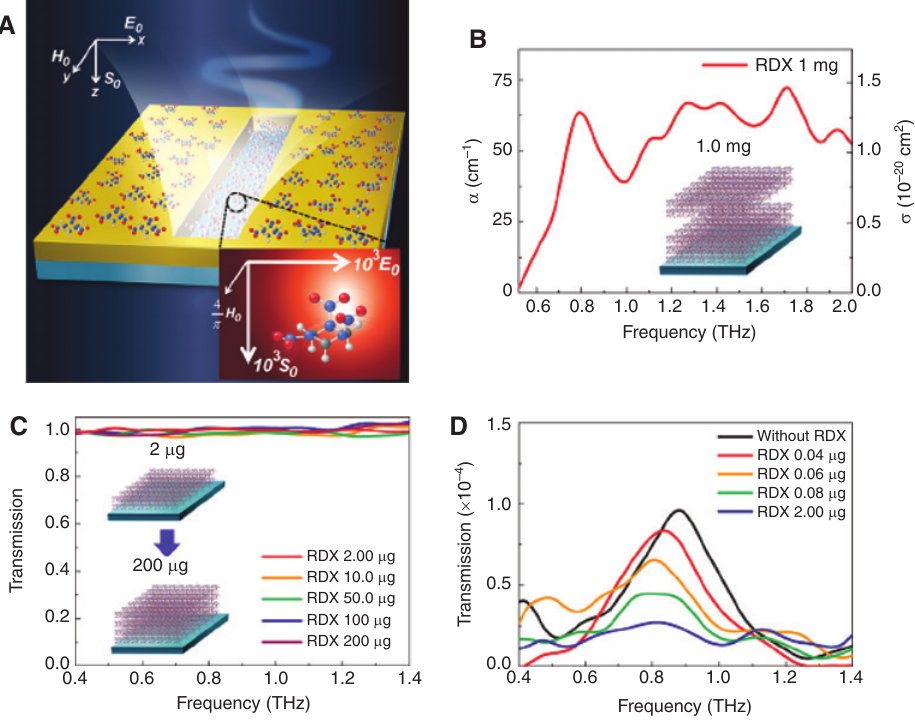
Figure 23: Interaction of molecules with THz nano antennas. (A) Schematic of the enhanced absorption cross-section of RDX molecules inside a THz nanogap. (B) Absorption spectrum for 1 mg of RDX molecules onto the bare substrate. (C) Transmission spectra for RDX onto the substrate without nanogap. (D) Transmission spectra for a single THz nanoslot antenna without and with RDX ranging from 40 ng to 2 μ g. This figure is reproduced from Ref.